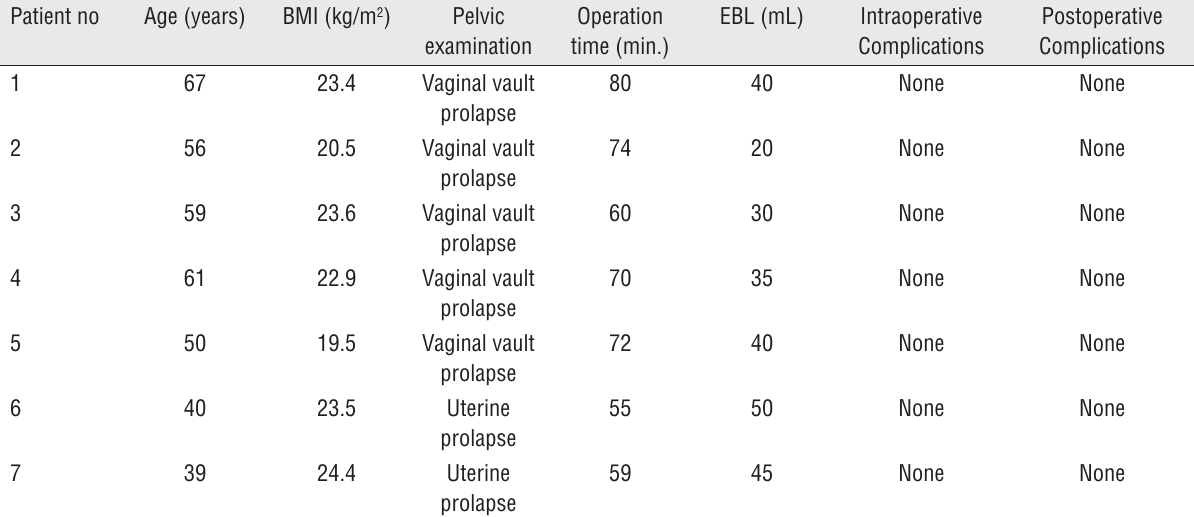
BMI = body mass index; EBL = estimated blood